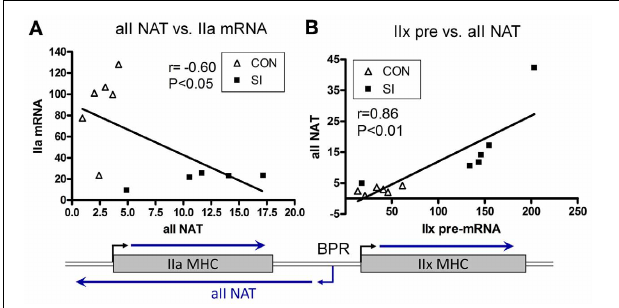
FIGURE 9 | Chromatin state and gene transcription. Model for chromatin factors interacting with transcription factors to regulate transcription of a gene. Histone modifications and DNA methylation are important factors in regulating the chromatin from active to repressed and vice versa. Histone H3 acetylation and histone H3 methylation and lysine 4, are both associated with an active chromatin state. In contrast, histone H3 methylation at lysine 9 or lysine 27 as well as DNA methylation are associated with repressive chromatin state. Chromatin is in a dynamic equilibrium between the two